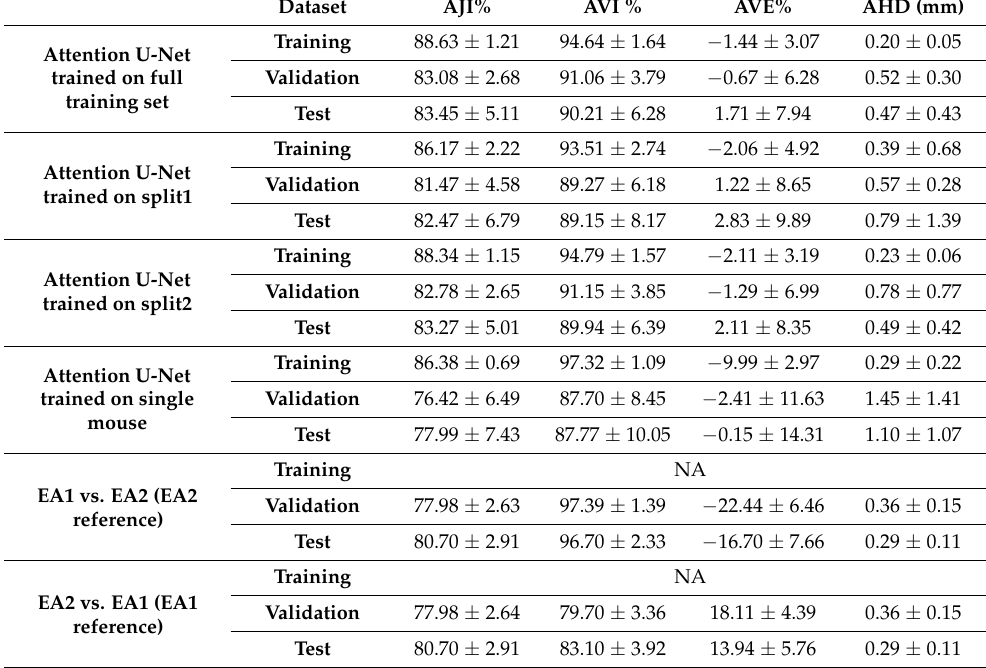
Table 1. Summary of segmentation accuracy metrics (mean ± standard deviation (SD)) for both experts and DL model with different training split scenarios (full, split 1, split 2, and single mouse). Dataset AJI% AVI % AVE% AHD (mm) Attention U-Net trained on full training